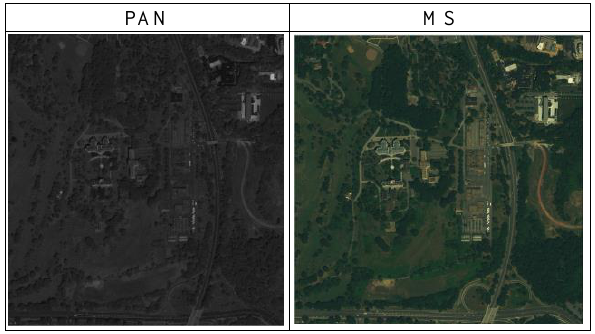
Figure 4. Data set 3, Washington DC-2 image set.